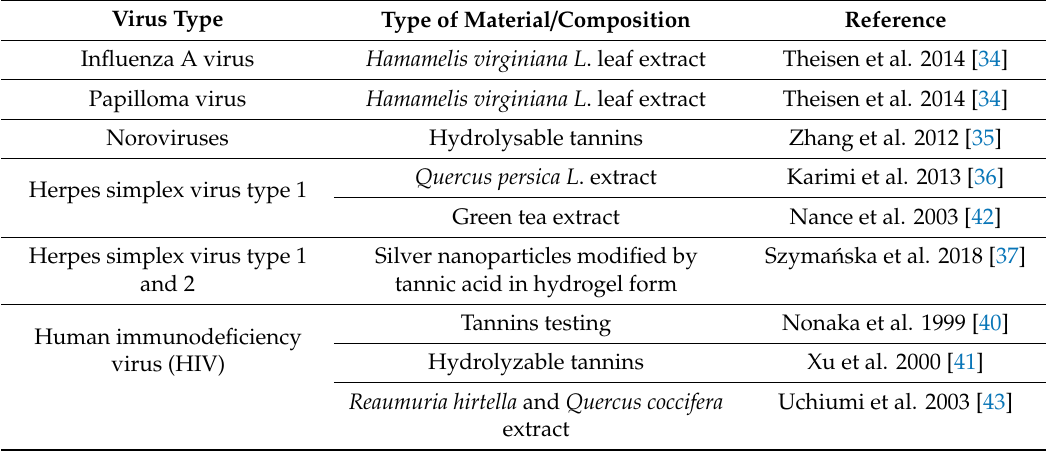
Table 1. Summary of tannic acid antiviral activity